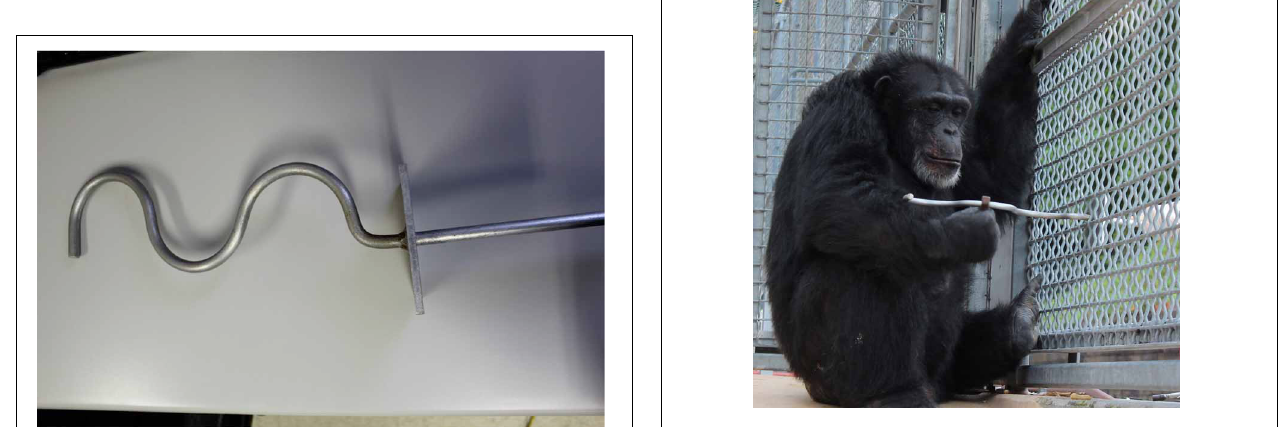
FIGURE 1 | Curved metal rod used to test intermanual transfer of learning.